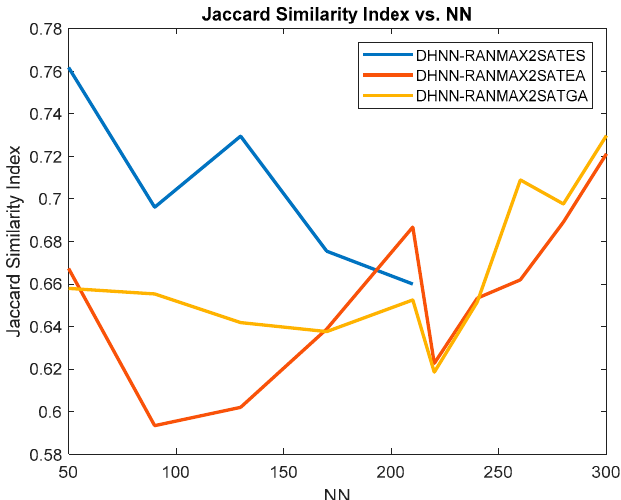
Figure 6. Jaccard Similarity Index, JSI produced by the DHNN-RANMAX2SAT.